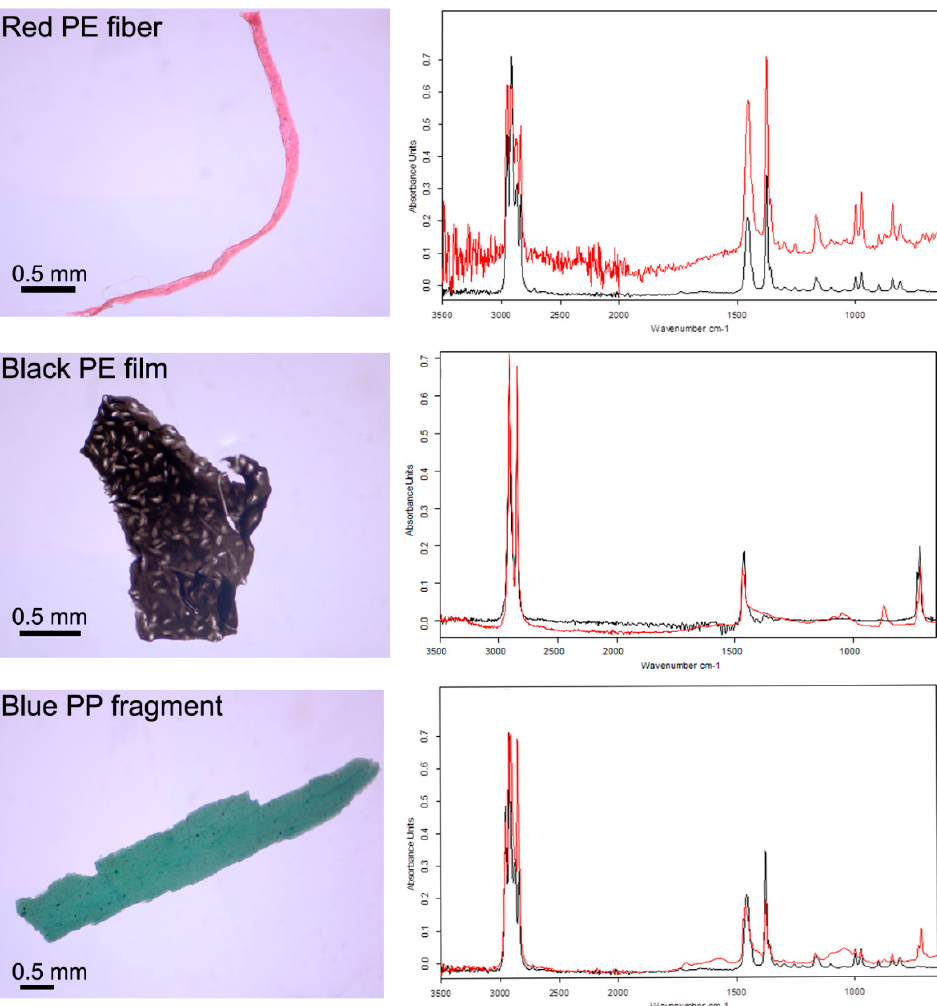
Figure 3. Fourier-transform infrared (FTIR) spectra of representative samples identified as polyethylene (PE) (both red fiber and black film) and polypropylene (PP) (blue-green fragment). Sample spectra are shown as red and compared to known reference samples in black. Samples exhibited weathering and oxidation, as shown by the presence of additional broad peaks, e.g., at wavelengths of 1620–1750 cm − 1 and 1100 cm − 1 in the spectra of the blue PP fragment.